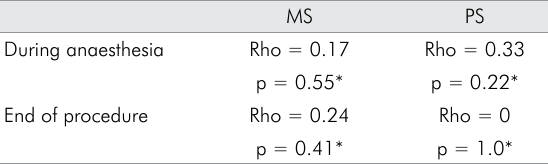
Table 3. Correlation between salivary cortisol levels and struggling behaviour during dental treatment of children under midazolam sedation (MS) or placebo